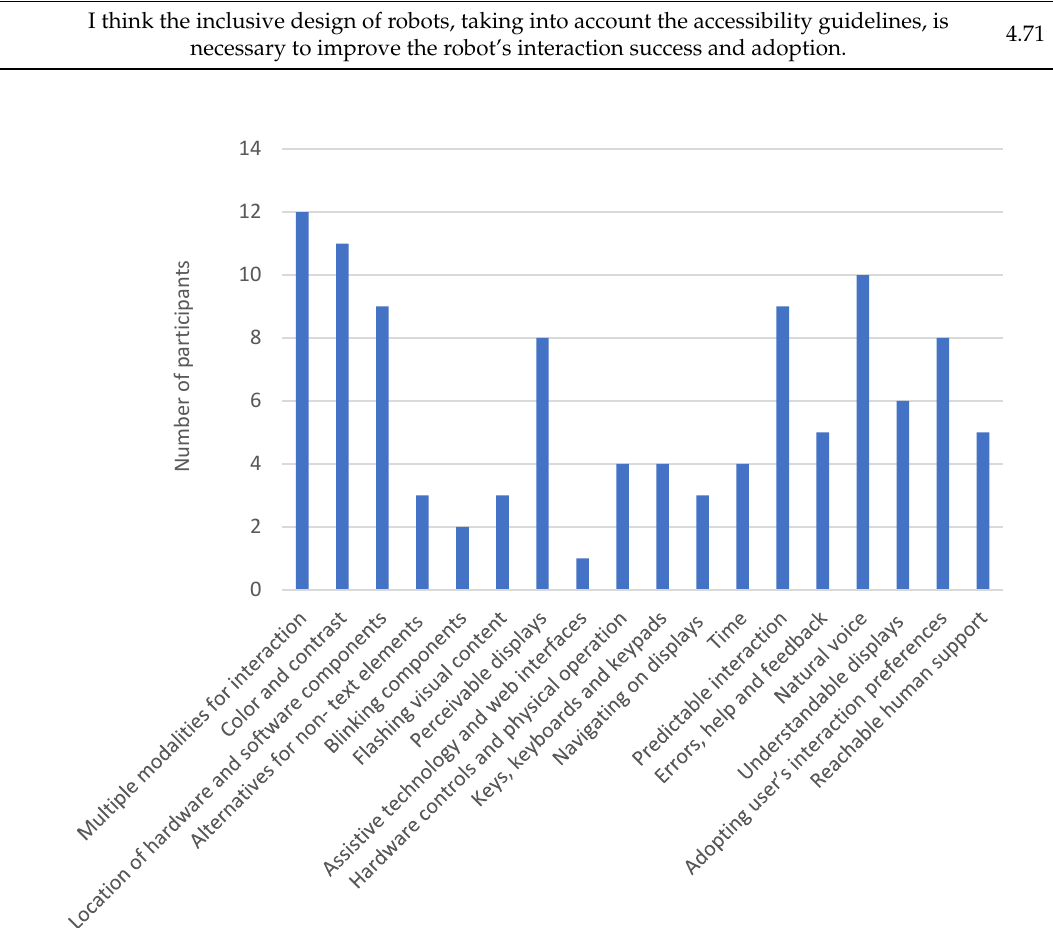
Figure 4. Number of participants who previously used each guideline.